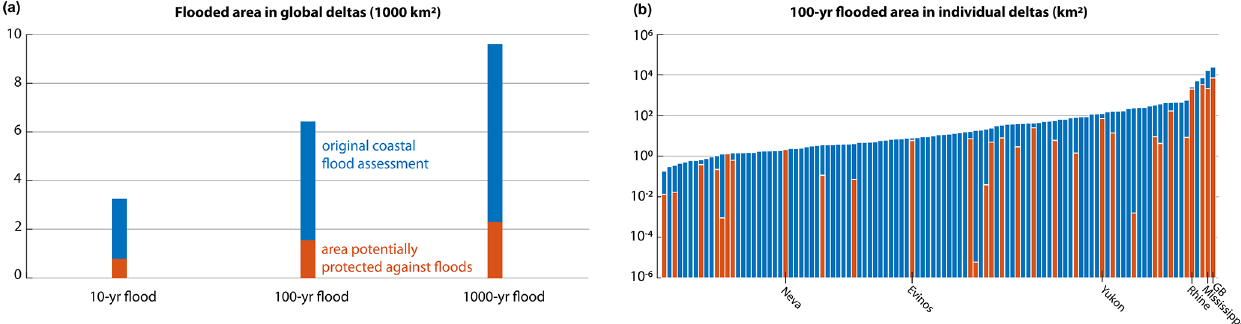
Figure 8. Delta area potentially protected against coastal floods (in red), compared to all exposed delta area (in blue), for all deltas (a) and individual deltas (b) . GB in the